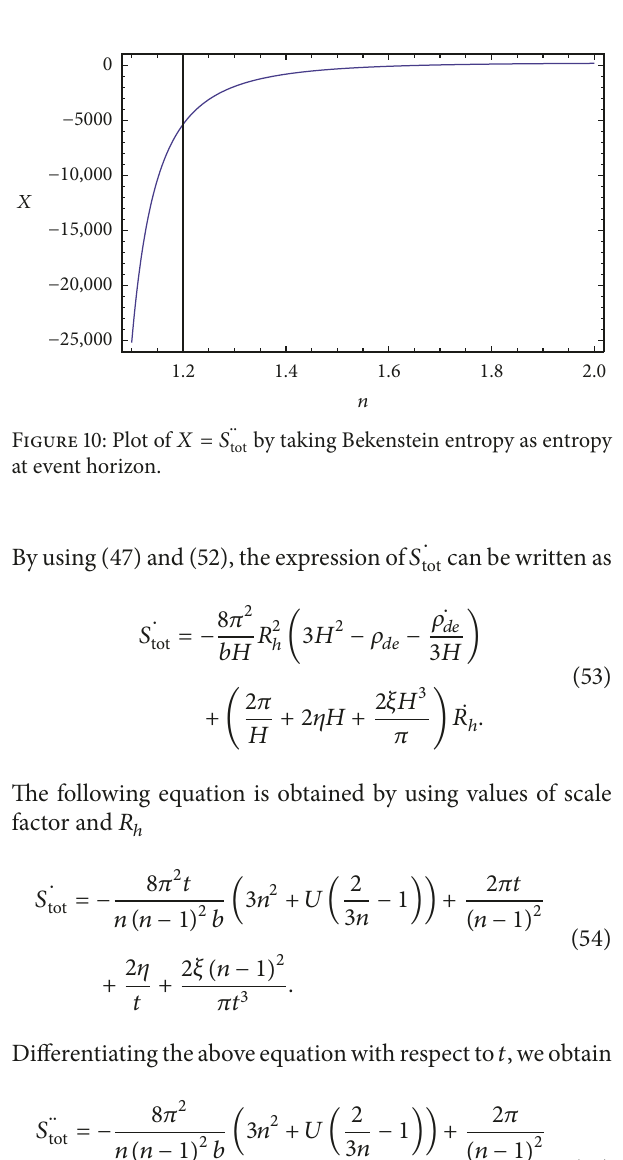
̈𝑆 Figure 8: Plot of 𝑋 = tot by taking power law entropy as entropy at apparent horizon, where time is measured in seconds.